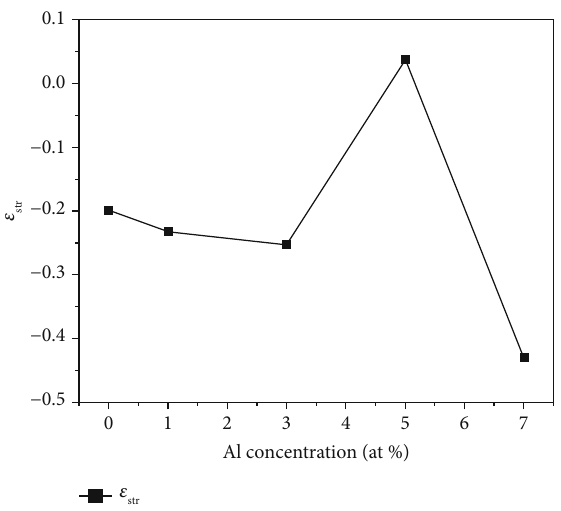
thin fi lms codoped with Al- 2